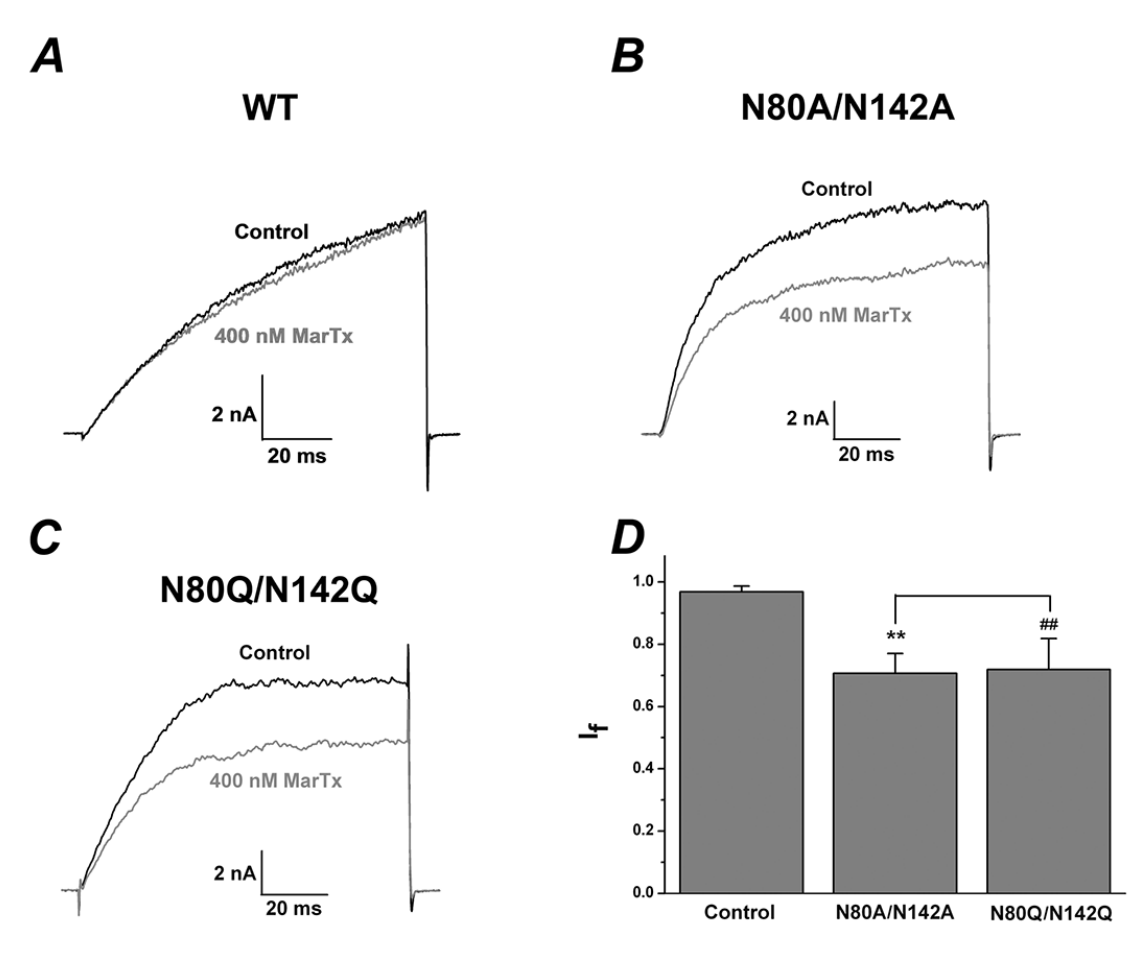
Figure 4. Deglycosylation of β 1 subunit altered the pharmacological effect of martentoxin on BK channels ( α + β 1) in the absence of cytoplasmic Ca 2+ . (A) Representative whole cell current traces from HEK 293T cells expressing wild-type BK channels ( α + β 1) before and after the application of martentoxin 400 nM. The holding voltage was -80 mV and the currents were elicited by a pulse of +100 mV. (B) Representative whole cell current traces from HEK 293T cells expressing mutant BK channels N80A/N142A before and after the application of martentoxin 400 nM. (C) Representative whole cell current traces from HEK 293T cells expressing mutant BK channels N80Q/N142Q before and after the application of martentoxin 400 nM. (D) Statistical analysis of pharmacological modulation of wild-type BK channels ( α + β 1) (n = 3) and N80A/N142A (n = 3, **p < 0.01) or wild-type BK channels ( α + β 1) (n = 3) and N80Q/N142Q (n = 4, ##p < 0.01) by martentoxin 400 nM. The inhibition ratios of martentoxin on the currents of N80A/N142A and N80Q/N142Q were not significantly different (p > 0.05).